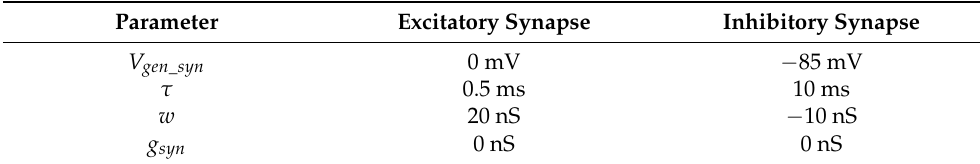
Table 2. Parameters for the excitatory and inhibitory synapses.